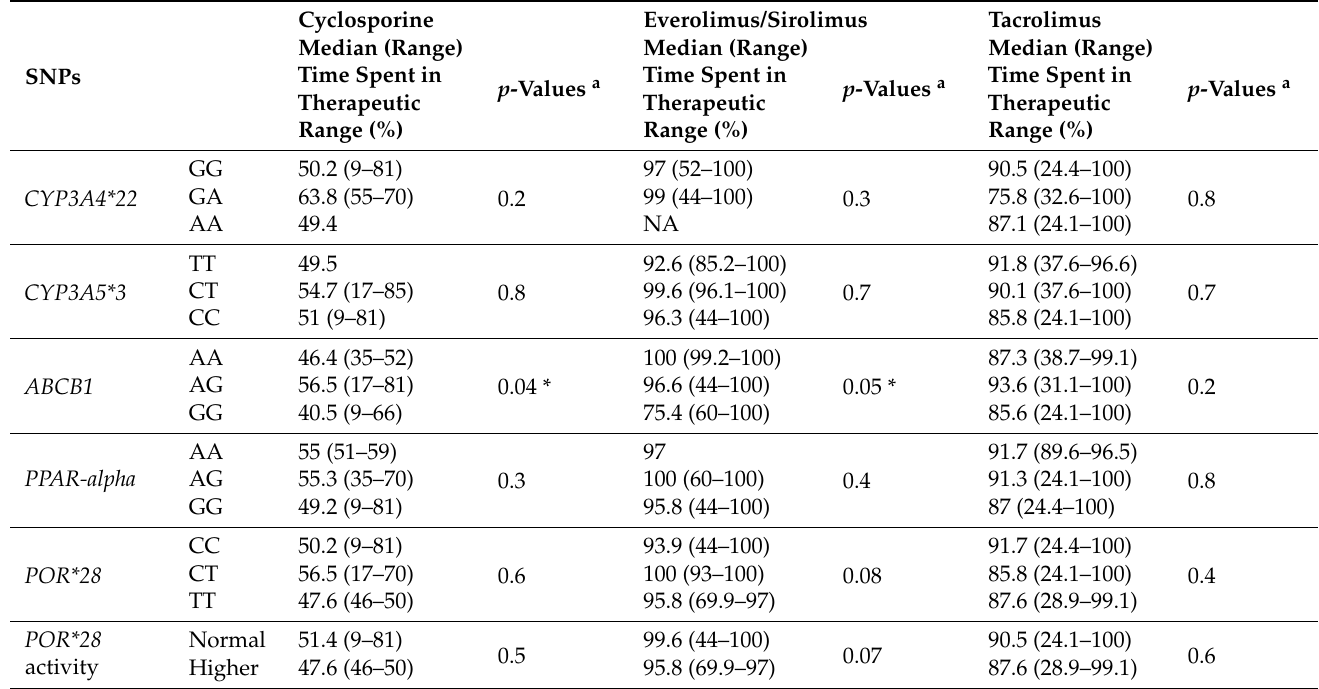
Table 7. Comparison of SNPs with the time spent in the therapeutic